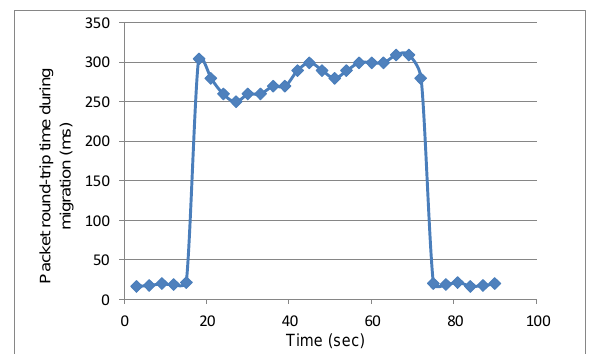
Figure 13. Packet round trip